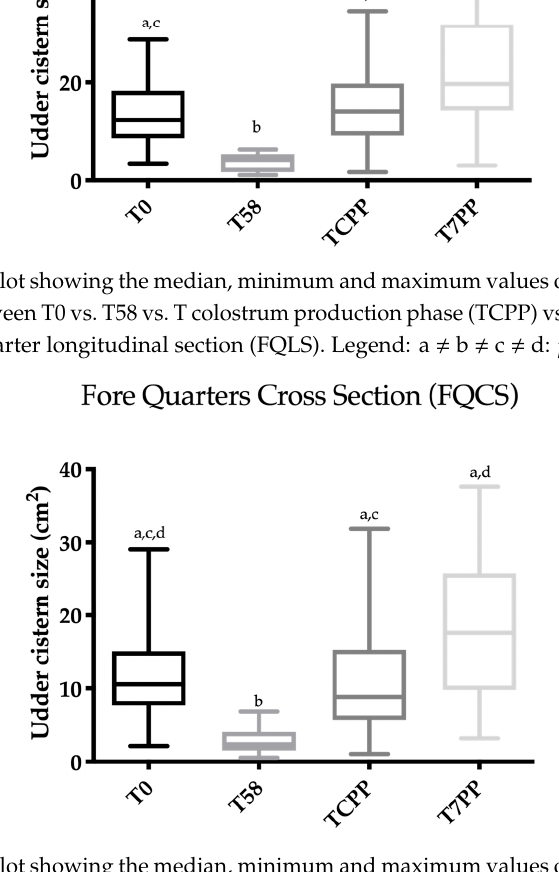
Figure 7. Scatter box plot showing the median, minimum and maximum values of the ultrasonographic udder cistern size between T0 vs. T58 vs. T colostrum production phase (TCPP) vs. T 7 days post-partum (T7PP) for the hind quarter cross section (HQCS). Legend: a ≠ b ≠ c ≠ d: p < 0.05. 3.4. Evaluation of the Ultrasonography Images The visual aspect of the forequarters’ UC changed during the dry period, passing from a wide arborized pattern to an elongated/round shape, while the rear quarters showed a less marked decrease in UC arborization. From the 38th day of the dry period, the UC margins passed from being clear to being blurred. At TCPP, the UC margins resumed their initial definition. No images showed an increase in the echogenicity of the UC contents and the surrounding mammary tissue (Figure 8).